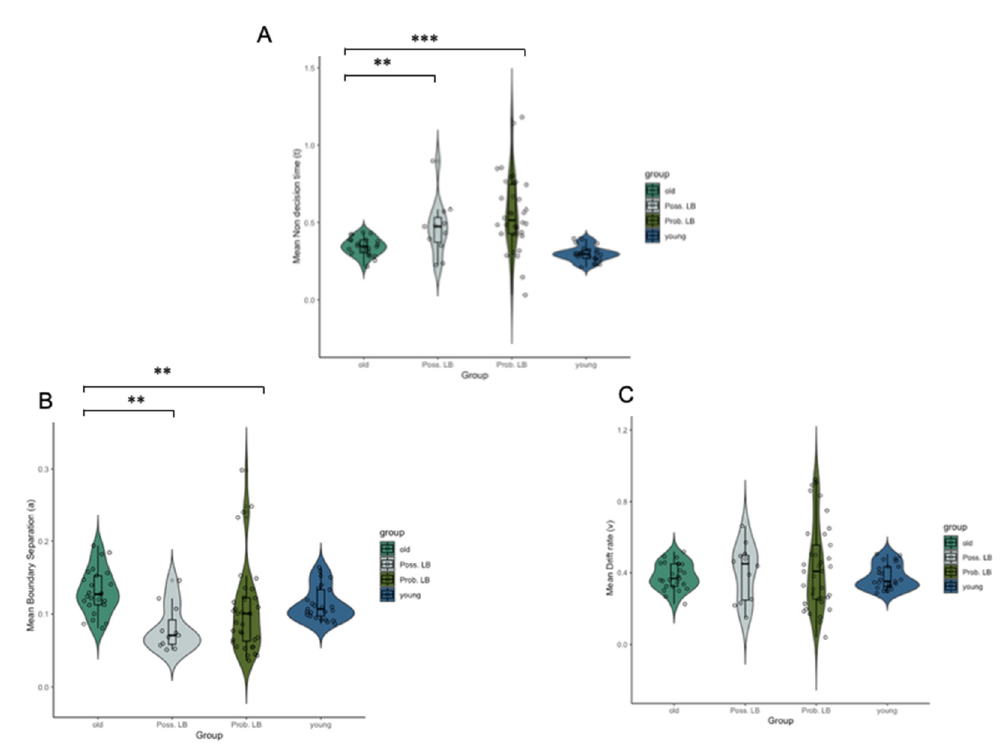
Figure 3. Diagnostic group differences in ( A ) non-decision time (t) and ( B ) boundary separation (a) and ( C ) drift rate DDM values. * p cor = 0.05, ** p cor = 0.01, *** p cor ≤ 0.001.